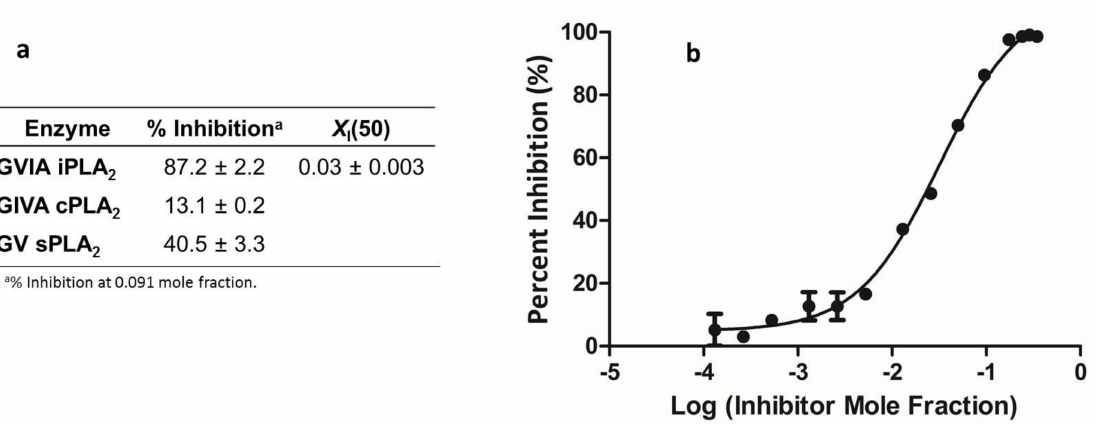
Figure 3. Inhibition of PLA 2 s by 19a ( a ). Dose–response inhibition curve for GVIA iPLA 2 for 19a ( b ). The curve was generated using GraphPad Prism with a nonlinear regression targeted to a symmetrical sigmoidal curve based on plots of % inhibition vs. log(inhibitor concentration). The reported X I (50) value was calculated from the resultant